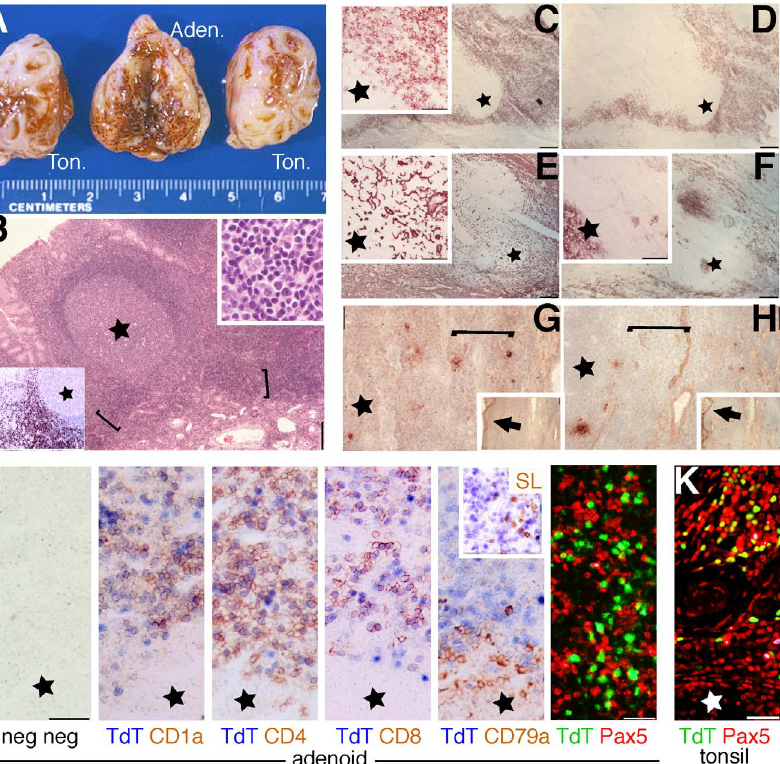
Figure 1. Phenotype and distribution of immature T cells in adenoids and tonsils. A: macroscopic appearance of a representative sample of tonsils and adenoidal tissue. B: Low power (4x) image of a fixed and embedded adenoid, stained with Hematoxylin and Eosin. The brackets highlights the boundary between the stroma and the secondary lymphoid tissue (star = germinal center) where darker staining small lymphocytes gather. Left lower corner inset shows TdT + (brown) cells in sheets in an immunostained serial section (4x). Upper right inset: H&E detail of the bracketed area (40x). C-H: frozen adenoid serial sections (4x) stained for CD1a (C), CD1b (D), TE-7 (E), NGFR/p75 (F), and the anti thymic epithelium reagents RFD4 (G) and TE-4 (H) (brown, no counterstain). The insets in C, E and F show a magnified detail of the area occupied by immature T cells (40x)(also indicated by brackets). Star = germinal center. The insets in G and H show low power images (4x). The arrows highlight positive surface epithelium. I: frozen adenoid serial sections (40x) double stained for negative controls, TdT and CD1a, CD4, CD8, CD79a and surrogate light chain (SL; inset). Note the doublestaining in the upper half field, except for CD79a and SL. The last image is a double immunofluorescence image showing largely mutually exclusive distribution of Pax5 and TdT in adenoids in a fixed and embedded section. K: fixed and embedded tonsil section showing coexpression of TdT and Pax5 in immature B cell precursors. ectopic cervical thymus. TE7 + , p75/NGFR-, RFD4-, TE4-2G10-